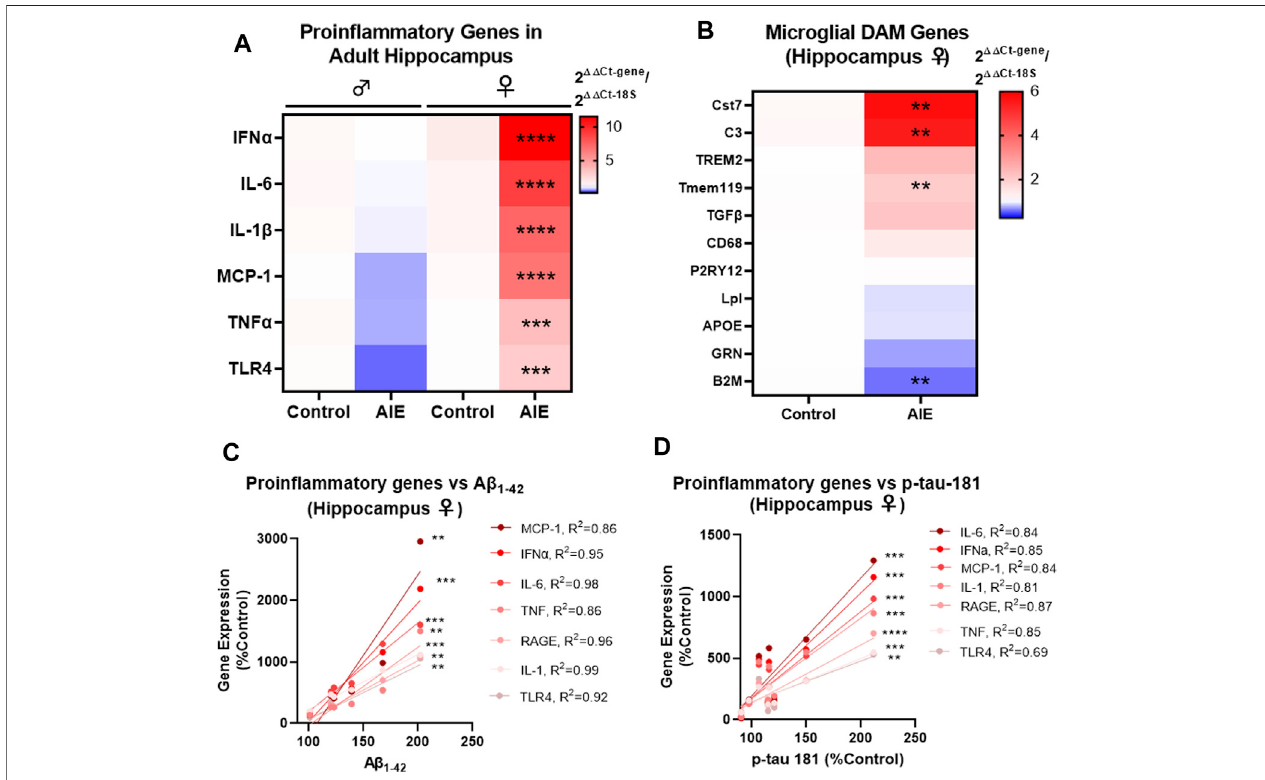
FIGURE4| AIEpersistentlyinducesin fl ammationinadult(P200)femalebrainthatcorrelatewithlevelsofA β andtaupathology.3xTg-ADmiceunderwenteitherAIE (5 g/kg/day, i.g.,2-days on2-daysoff,P25-55)orwatergavageandhippocampusat P200wasassessed forproin fl ammatory andmicroglialgenesbyRT-PCR. (A) AIE persistentlyincreased proin fl ammatory gene expression in IFN α , IL-6, IL-1 β , MCP-1, TNF α , and TLR4 in thefemale hippocampus. 2-way ANOVA with Sidak ’ s post-test and FDR p -value correction, ***q < 0.001, **** q < 0.0001. N = 6 control, 7 ethanol. (B) AIE signi fi cantly altered the expression of microglial DAM genes Cst7, C3, Tmem119, and B2M in the female hippocampus at P200 relative to control. Mann-Whitney t- tests with FDR correction, ** q < 0.01. N = 6 control, 7 ethanol. (C) Proin fl ammatorygeneexpression waspositivelycorrelatedwithlevelsofneurotoxic solubleA β 1 – 42 protein (westernblot) infemale hippocampus withPearson R 2 values between0.86and0.99. (D) Proin fl ammatorygeneexpressionwaspositivelycorrelatedwithp-tau-181proteinlevels(westernblot)infemalehippocampuswithPearson R 2 values between R 2 = 0.69 and R 2 = 0.87 with p values ** < 0.01, *** < 0.001, **** <